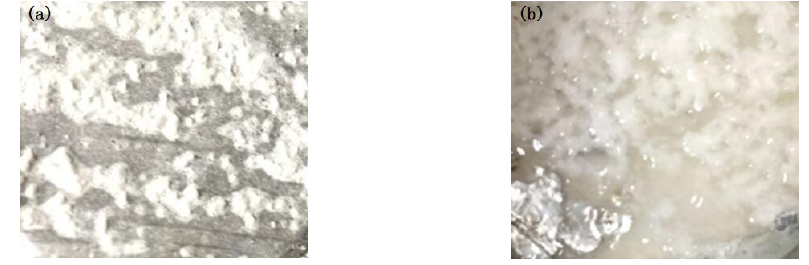
Figure 13. The tensile fracture morphology of sample 3-3: (( a ) aluminum foil; ( b ) DSPE).